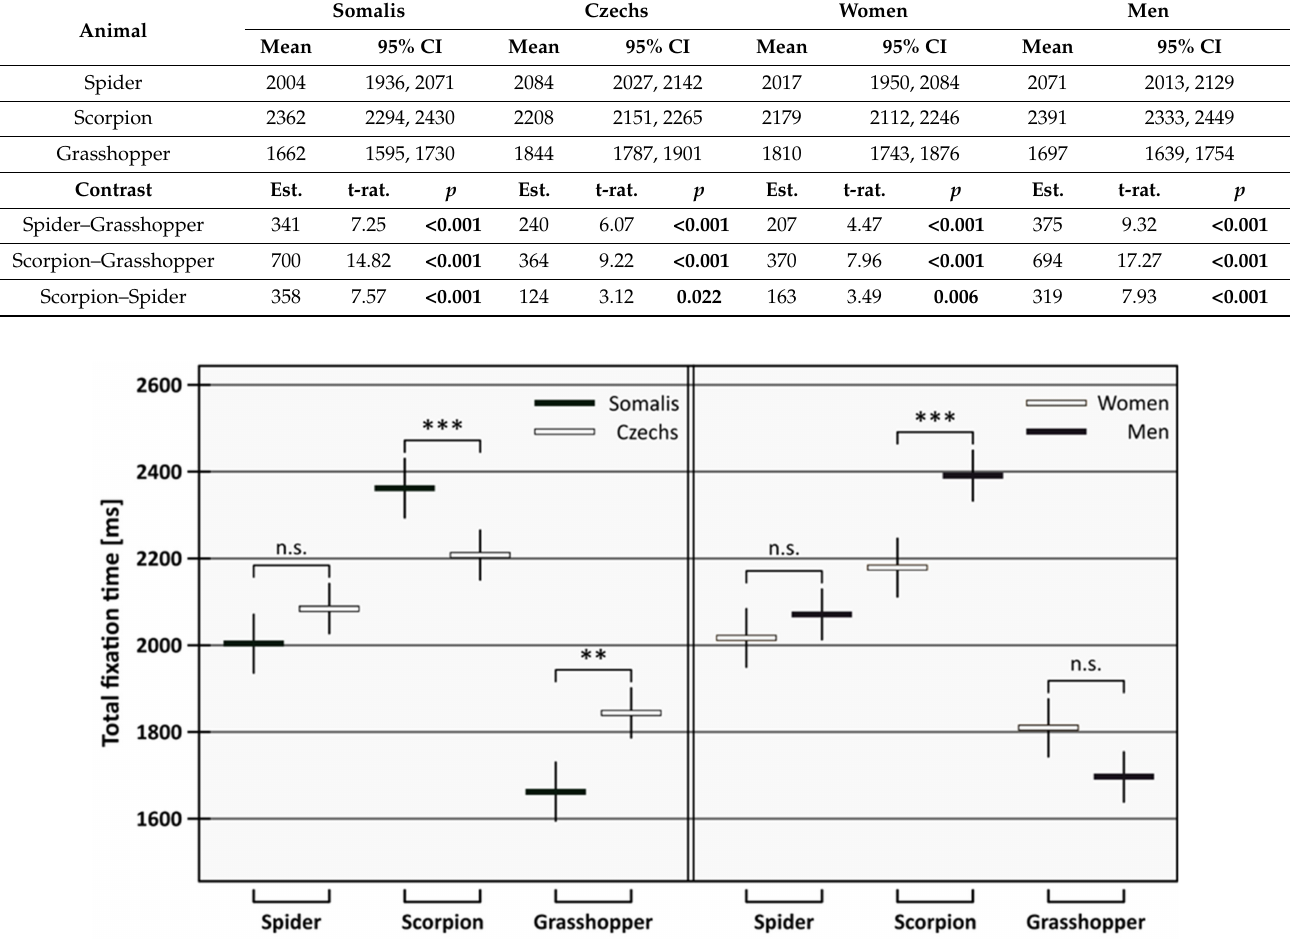
Figure 2. Total fixation time on the animal stimuli for Somalis and Czechs ( left panel) and women and men ( right panel). Error bars are 95% confidence intervals. Means are tested using Tukey post hoc test, significances are indicated by asterisks (n.s. p ≥ 0.05; ** p < 0.01; *** p <